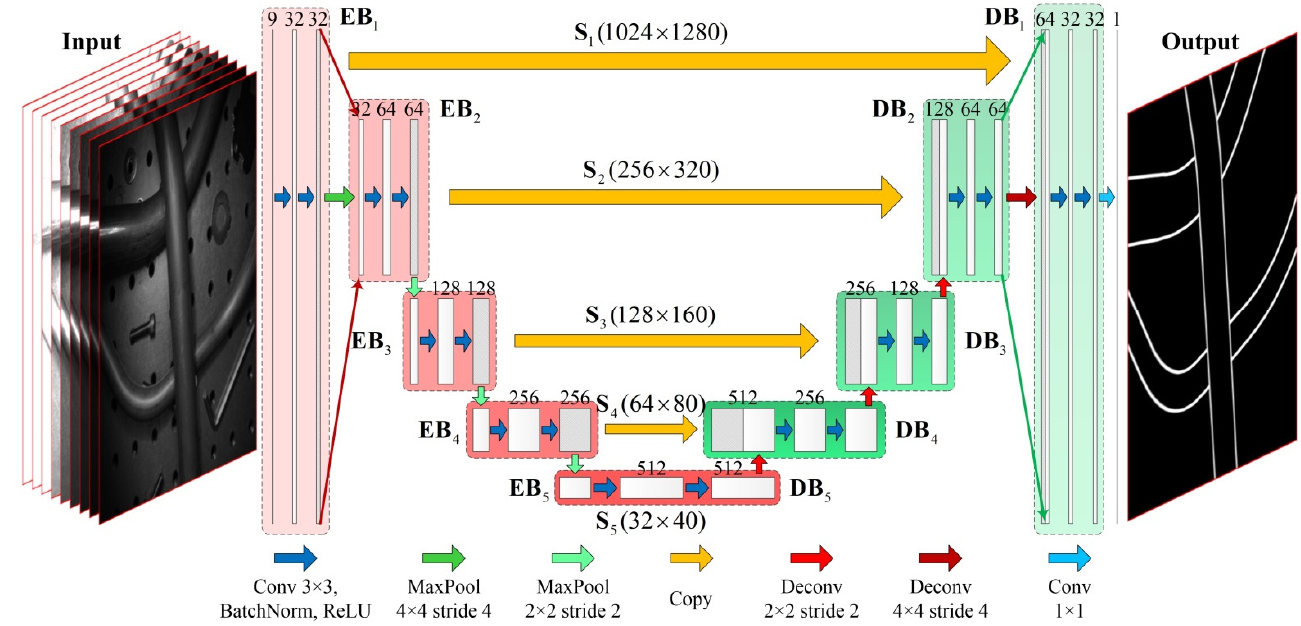
Figure 2. The architecture of the designed FCN.